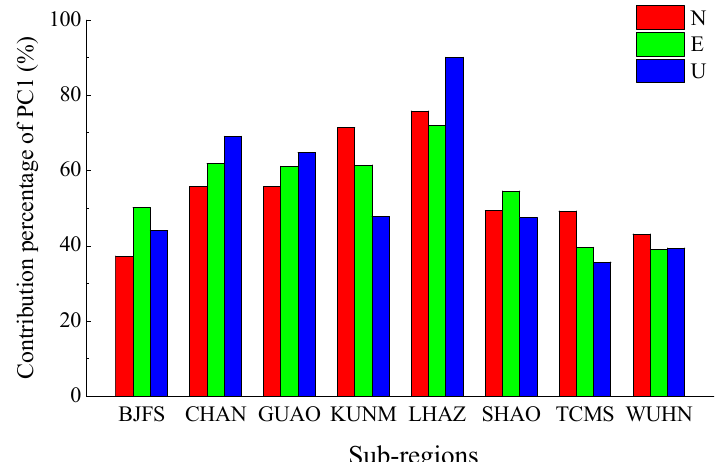
Figure 7. Contribution percentage of PC1 in eight sub-regions. The column “TCMS” shows the corresponding percentage in the district contains all three IGS stations in Taiwan. Similarly, “GUAO” stands for the region where GUAO and URUM stations locate.